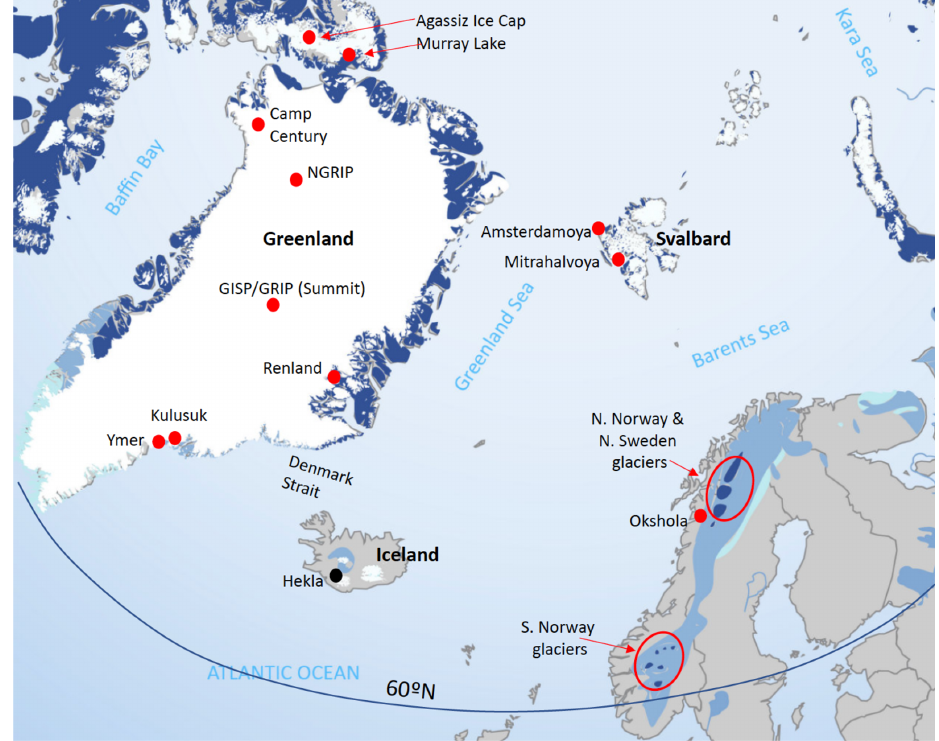
Figure 5. Location of sites mentioned in the text and in figures.